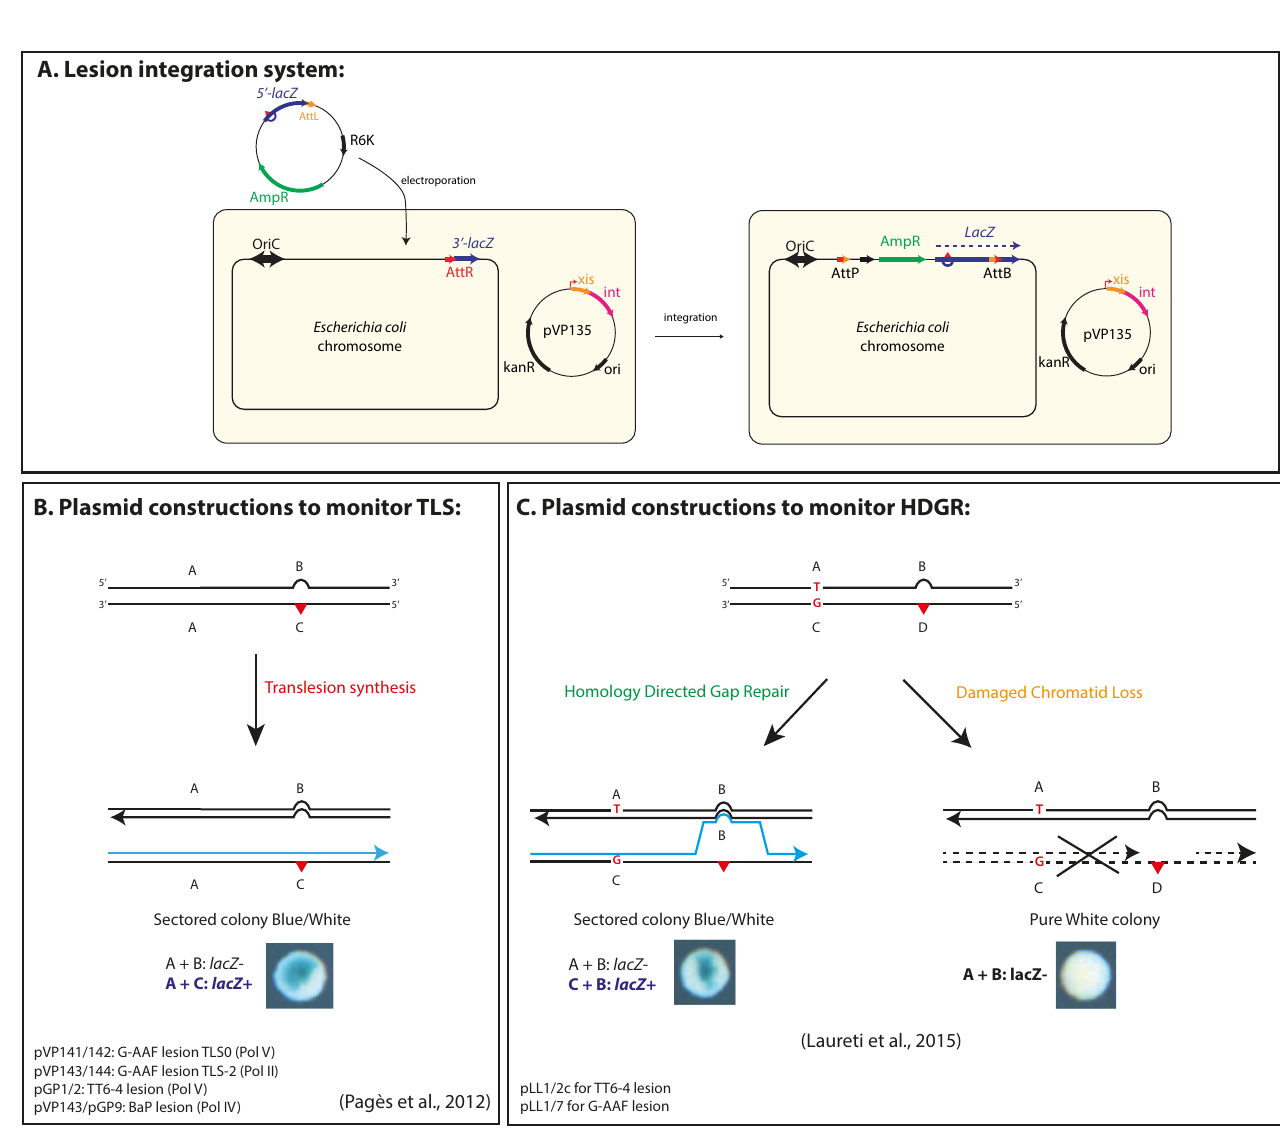
Fig 1. Lesion tolerance assay and lesion containing plasmids. A) The system is based on the phage lambda site-specific recombination and it requires a recipient E . coli strain with a single att R site fused to the 3’-end of the lacZ gene and a non-replicating plasmid construct containing a single DNA lesion (red triangle) in the 5’-end of the lacZ gene fused to the att L site. The recombination reaction between att L and att R is controlled by ectopic expression of phage lambda int–xis proteins (provided by pVP135), and leads to the integration of the lesion-containing vector into the chromosome. Integrants are selected on the basis of their resistance to ampicillin and the chromosomal integration restores an entire lacZ gene (see also [44]). B) Plasmid duplexes used to monitor TLS events (see also [13,52]). The non-damaged strand (A+B markers) contains a short sequence of heterology opposite the lesion that inactivates the lacZ gene and serves as a genetic marker for strand discrimination. Only the replication by TLS polymerases of the A+C markers will give rise to a functional lacZ gene and therefore to a sectored blue-white colony. For the G-AAF lesion, one construct measures TLS0 events specific of Pol V-dependent TLS events, while another one contains a +2 frameshit that allows to measure TLS-2 events specific of Pol II when the G-AAF lesion is inserted in the NarI hotspot sequence (see also [51]). C) Plasmid duplexes used to specifically monitor strand exchange mechanisms, i . e . HDGR events (see also [12]). The system is a modified version of the plasmid constructs used to monitor TLS events. In these plasmids four genetic markers have been designed in order to distinguish the replication of the non- damaged strand (containing markers A and B) from the damaged strand (containing markers C and D). Using a combination of frameshift and stop codon, we inactivated lacZ gene on both the damaged (C-D) and undamaged (A-B) strands of the vector. Only a strand exchange mechanism by which replication has been initiated on the damaged strand (incorporation of marker C), and where a template switch occurred at the lesion site (leading to incorporation of marker B) will restore a functional lacZ gene (the combination of markers C and B contains neither a stop codon nor a frameshift); therefore leading to sectored blue- white colonies. When the damaged strand is lost, only the A and B marker will be replicating giving rise to a white